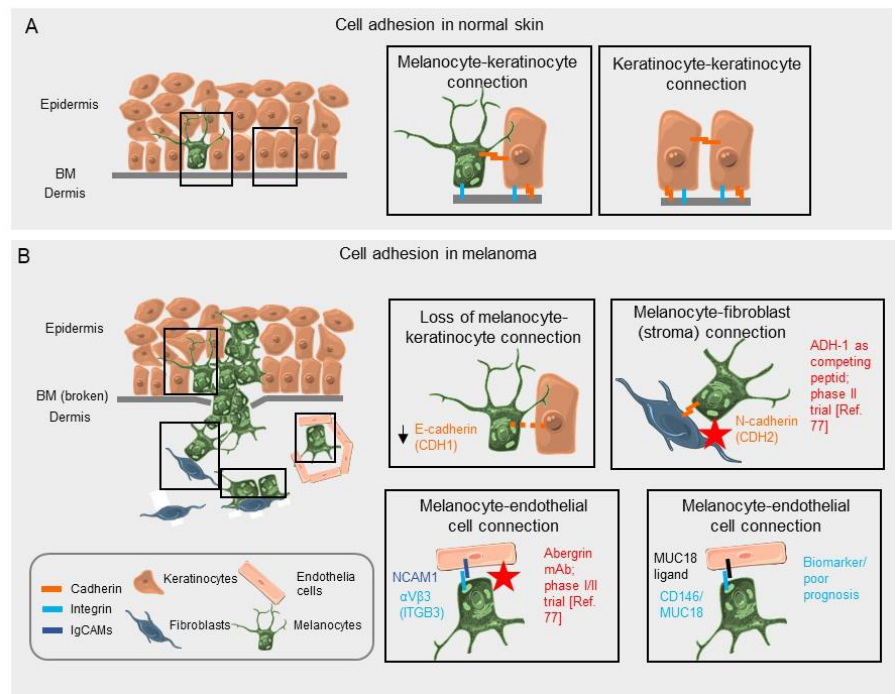
Figure 9. Mechanism of CAMs in normal skin and melanoma. ( A ) Schematic representation of CAMs in physiological skin. The melanocyte- BM connection is facilitated by integrin α6β1; keratinocytes connect via E-cadherin; keratinocytes and melanocytes connect via E-cadherin; and the keratinocytes- BM connection works through integrin α5β1, α3β1, α2β1, and α6β1 (different integrins bind different anchors i.e., collagen, laminins, ECM on the BM). ( B ) Schematic representation of CAMs in melanoma and indication of markers and drug targets. The loss of E-cadherin impacts the keratinocyte-melanocyte connection; expression of N-cadherin favours the connection of melanoma cells with stromal cells; expression of ITGB3 on melanoma cells favours connection to endothelial cells; and MUC18 expression enables the interaction with endothelial cells. The red star indicates that the interaction is a target for anti-melanoma drugs. The figure was prepared using images from Servier Medical Art by Servier (http://www.servier.com/Powerpoint-image-bank (accessed on